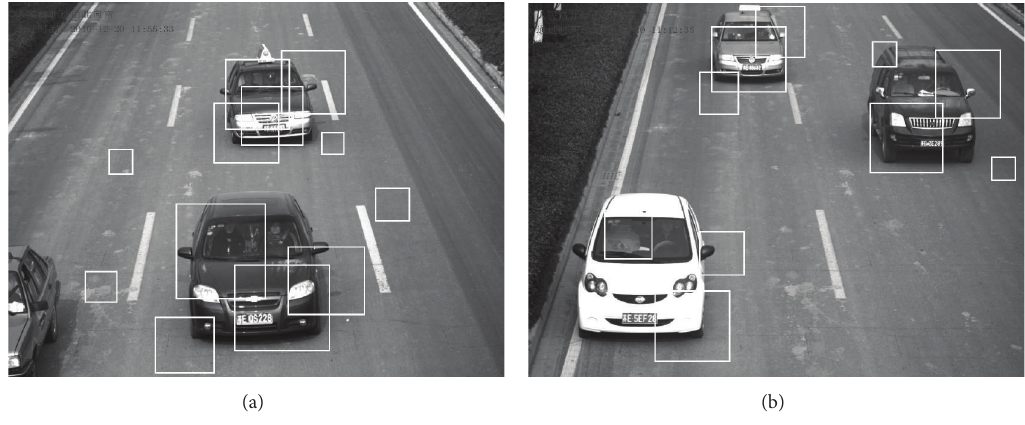
Figure 11: The detection result from Viola and Jones